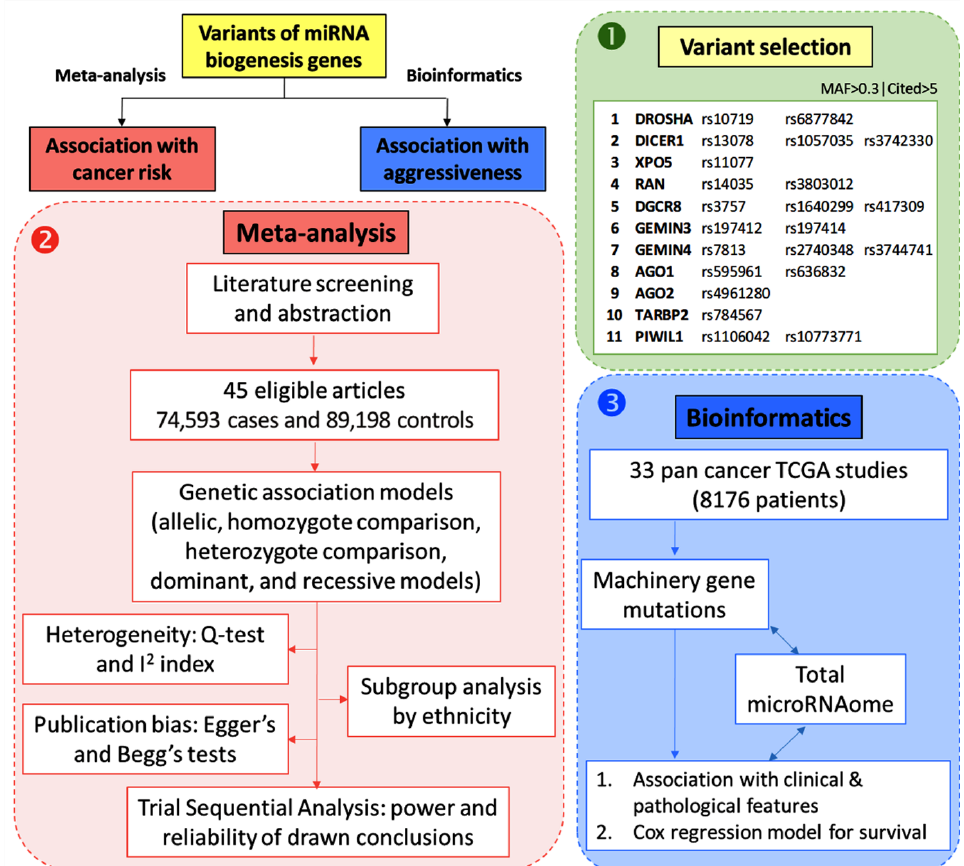
Figure 2. Workflow followed for in silico data analysis and meta-analysis. We followed three steps: (1) Selection of genes enrolled in microRNA machinery canonical pathway followed by a selection of genetic variants with five or more published articles and minor allele frequency (MAF) of more than 0.3 after identification of 11 genes, including 22 single nucleotide polymorphisms. (2) Meta-analysis was performed to pool the results of 45 published articles. Pairwise comparisons were carried out for each genetic association model to identify the association between gene polymorphism and cancer